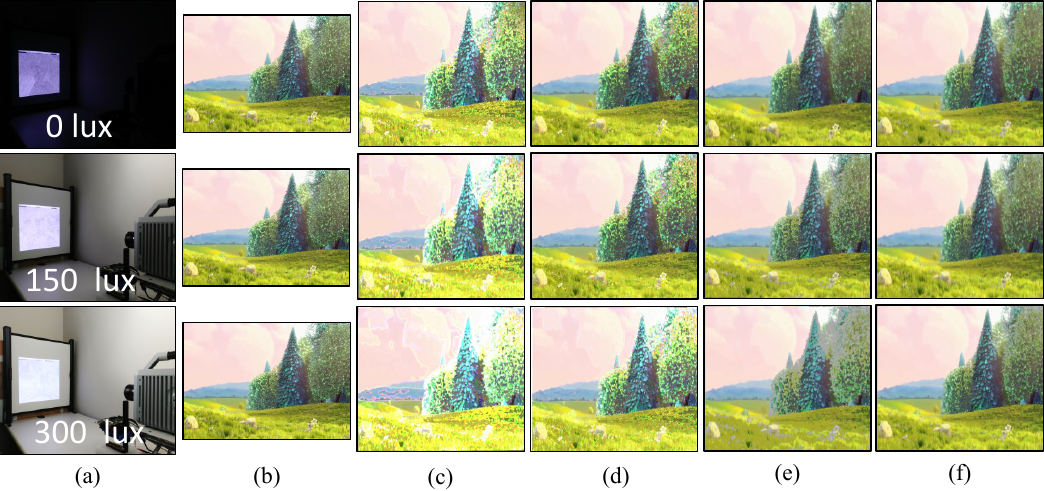
Figure 15. Plain background: ( a ) experiment scene at different illuminance levels; ( b ) 1920 × 1080 input images; ( c ) 510 × 459 images reconstructed using pure-binary-code without background subtraction; ( d ) 510 × 459 reconstructed images with pure-binary-code with background subtraction; ( e ) 510 × 459 reconstructed images using gray-code without background subtraction; and ( f ) 510 × 459 reconstructed images using gray-code with background